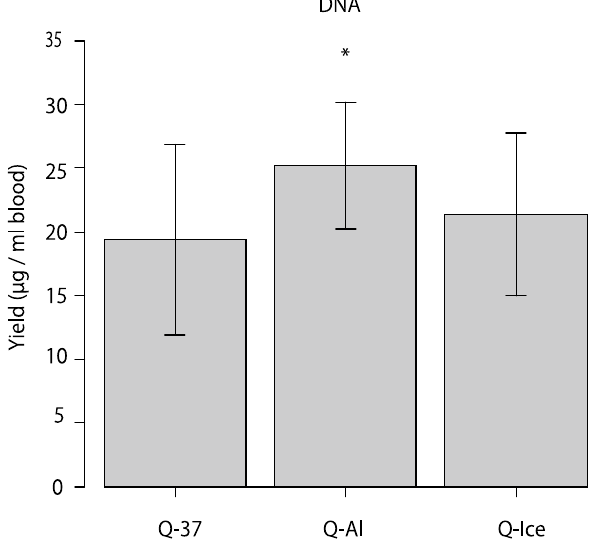
Figure 4. Comparison of the yield of DNA isolated from whole blood samples using protocols Q-37, Q-Al, and Q-Ice. Data are shown for each sample as mean ± standard deviation (n = 6). * p < 0.05 for Q-37 versus Q-Al and Q-Al versus Q-Ice (repeated-measures analysis of variance with Bonferroni correction). The image was created using EZR software version 1.54 (http:// www. jichi. ac. jp/ saita ma- sct/ Saita maHP. files/ statm edEN. html) and Adobe Illustrator CS5 (https:// www. adobe. com/).